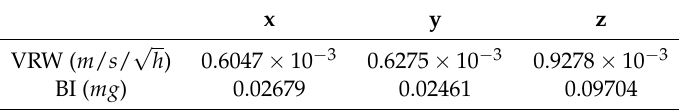
Figure 15. Velocity random walk and bias instability of the sensor z -axis. Table 3. Velocity random walk and bias instability for each